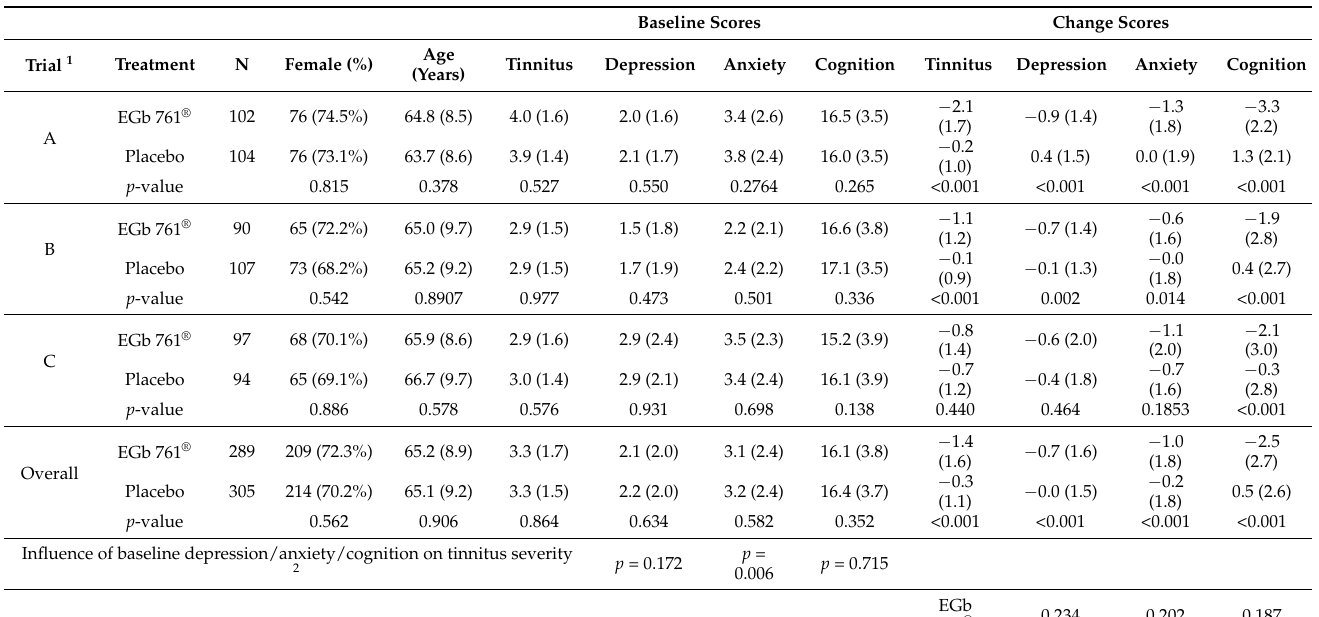
Table 1. Demographic data, baseline scores, changes during treatment and correlations of patients who had tinnitus at baseline (data from three trials, absolute and relative frequency and p -value of the two-sided χ 2 test or mean ± standard deviation, p -value of the two-sided t -test and Pearson correlation coefficient,